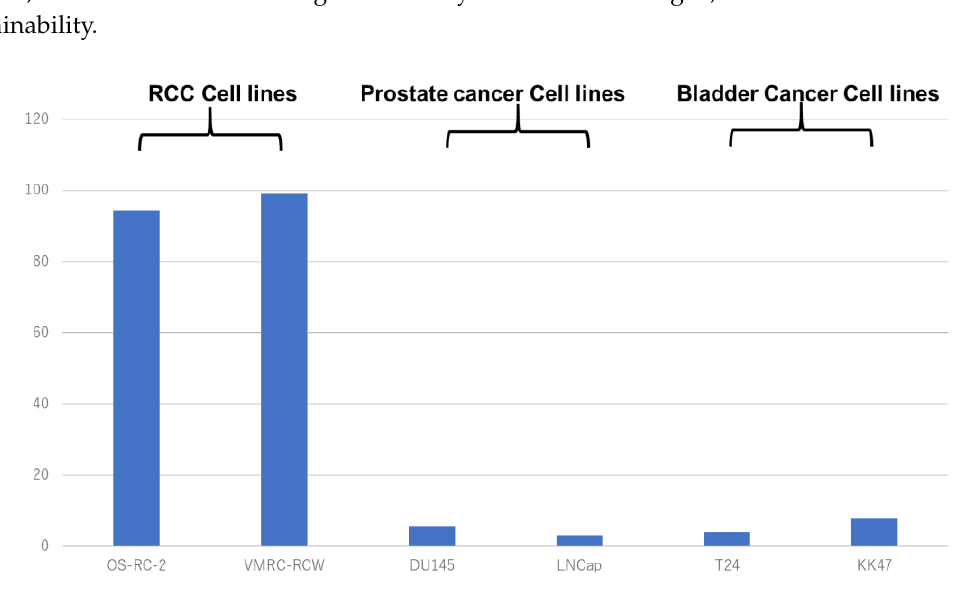
Figure 2. Anti-G250 antibody staining pattern in various cancer cell lines. Flow cytometric analysis of G250 expression on renal cell cancer (RCC) cells and other types of urological cancers (prostate cancers and bladder cancers).